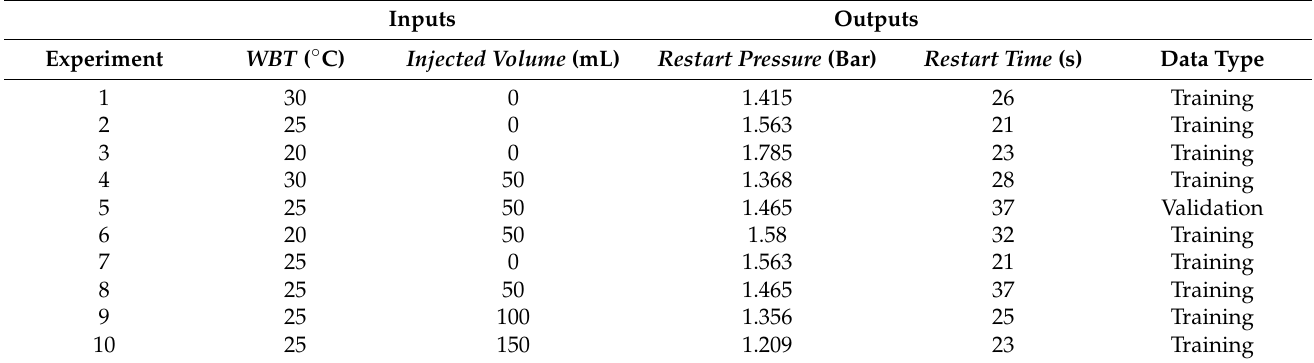
Table 2. Summary of the restart pressure and restart time of the instantaneous gas injection